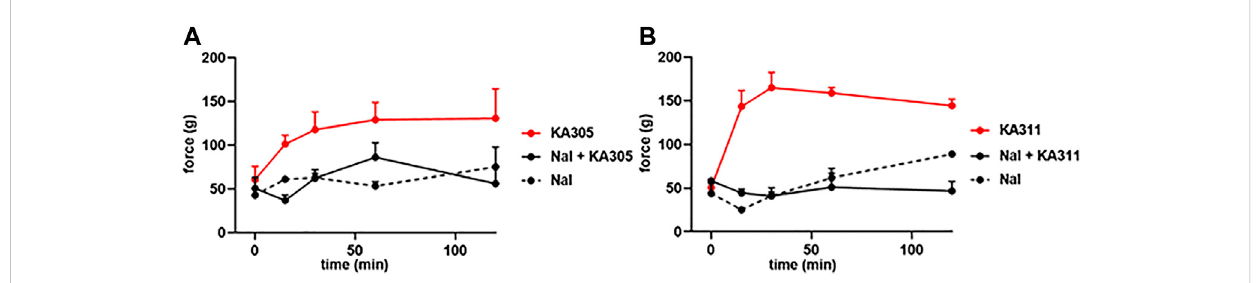
FIGURE 10 Effectofnaloxone(1 mg/kg)onpeptide-inducedantinociceptionintheFCAmodelfor (A) KA3050.3 mg/kg. (B) KA3110.3 mg/kg.Notetheeffectof each peptide is blocked by pre-administration of naloxone. Data shown are means ± SEM; n = 3 per